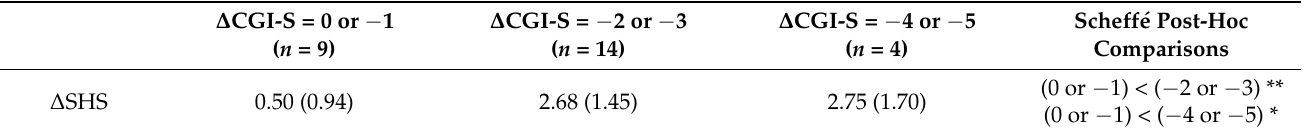
Table 3. SHS change scores ( ∆ SHS) according to the categories of clinical improvement derived from the CGI-S change scores ( ∆ CGI-S) ( n =